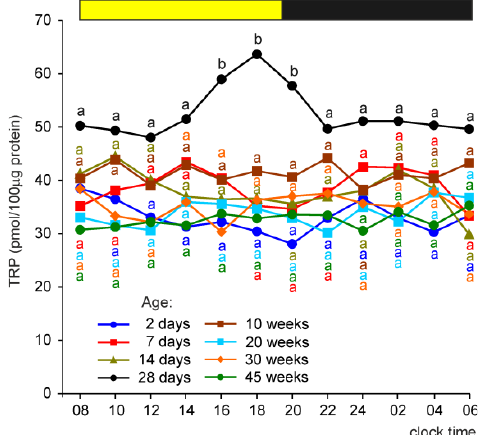
Figure 2. Concentration (means) of tryptophan in the pineal organs of turkeys at the ages of 2, 7, 14, 28 days and 10, 20, 30, 45 weeks. The horizontal bar represents the periods of light and dark phases of the daily cycle. The letters on the charts show differences between age groups at each time-point in Duncan’s test. The same letters indicate means which are not significantly different.